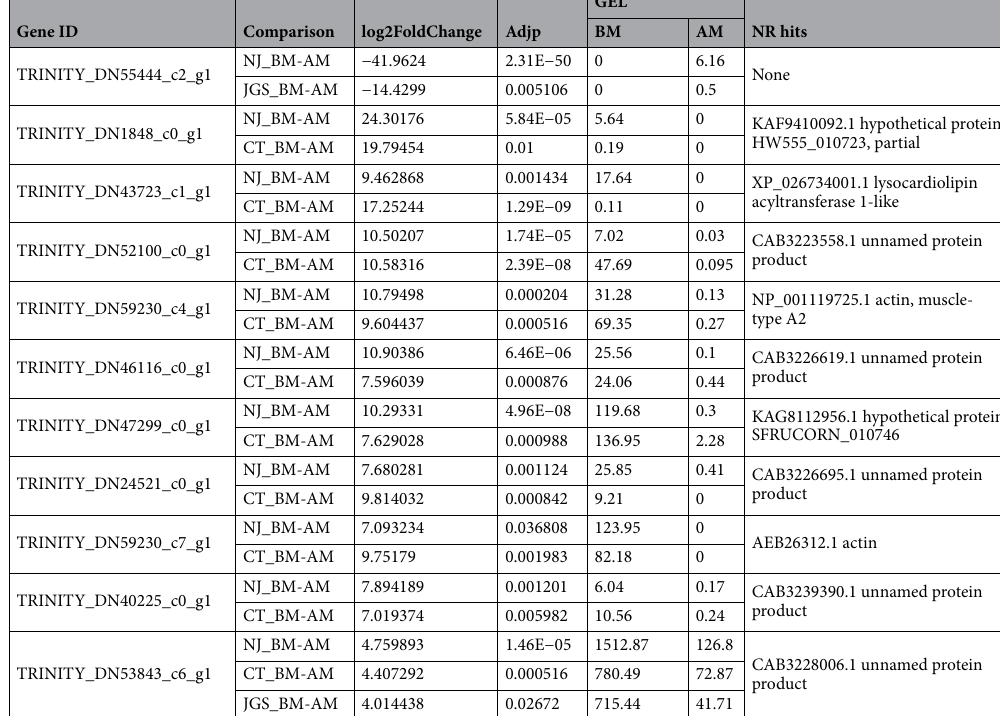
Table 6. Genes that were consistently differentially expressed (DEGs) in all comparisons of ASM and ESM transcriptomes developed from moths before mating (BM) and after mating and oviposition (AM). DEGs are sorted in descending order with respect to log2-fold change, with DEGs down-regulated in before-mating ESM transcriptomes listed first, followed by DEGs up-regulated in ESM before-mating